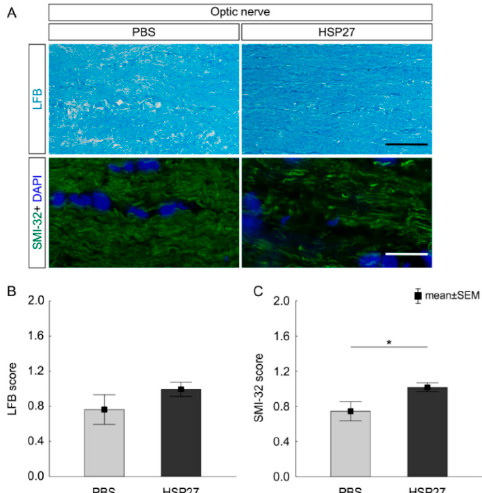
Figure 7. Intact myelin sheath and damaged neurofilament. ( A ) LFB was used to stain the optic nerve myelin sheaths. The antibody against SMI-32 (green) was applied to identify the neurofilaments in the optic nerve. The cell nuclei were stained with DAPI (blue). ( B ) 21 days after the HSP27 injection, no e ff ects on the myelin were noted via LFB scoring ( p = 0.27). ( C ) The SMI-32 score revealed a degeneration of neurofilaments in the HSP27 group ( p = 0.049). Scale bar = 20 µ m, n = 6 / group, * p <